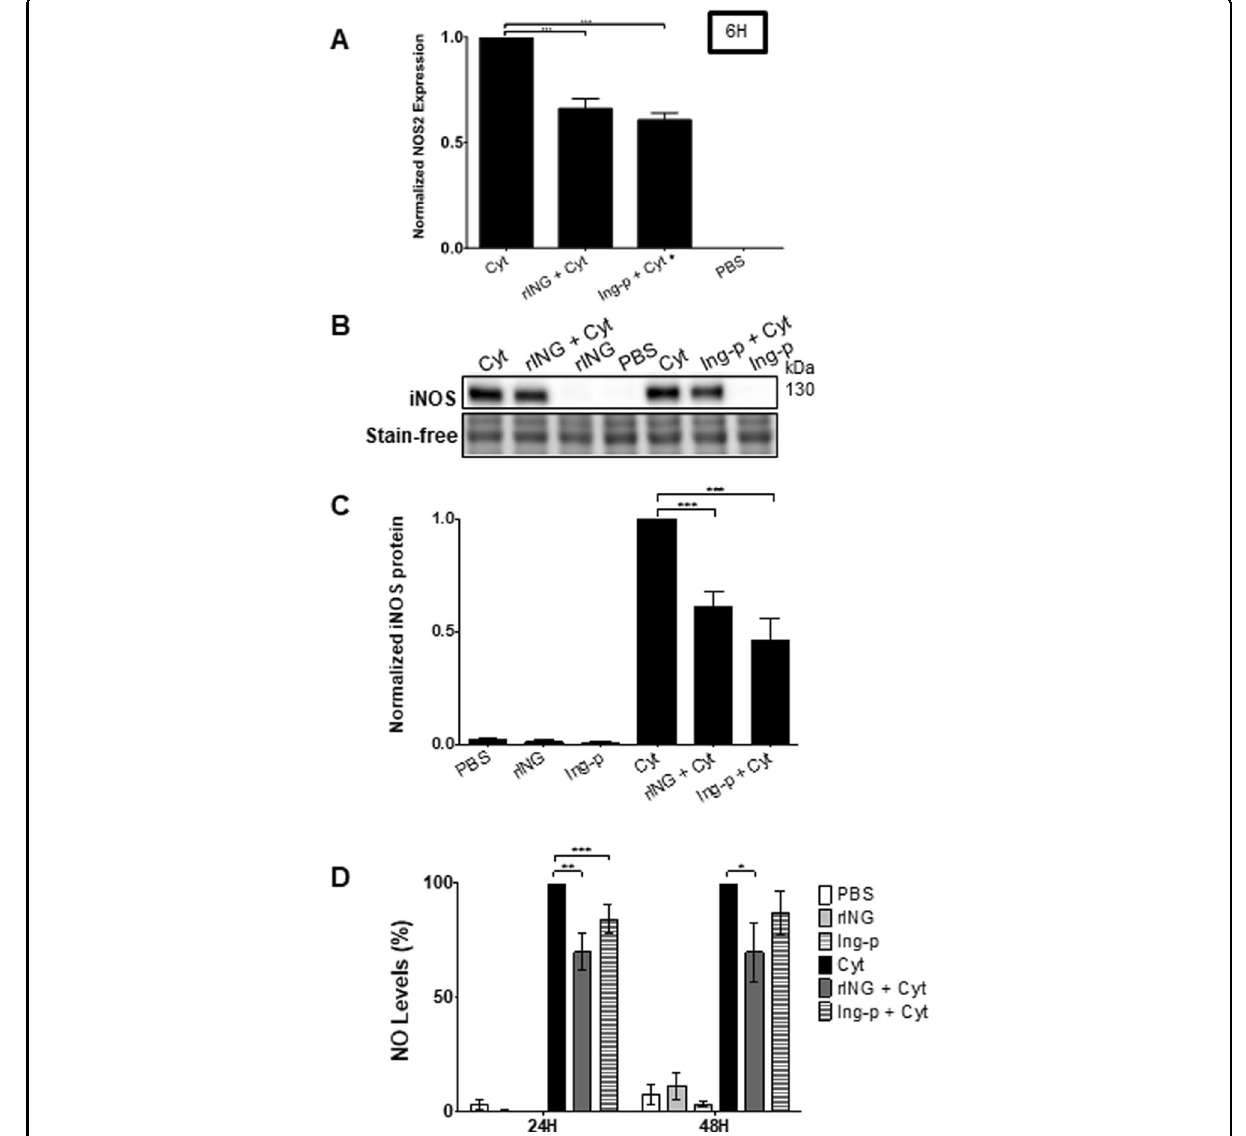
Fig. 2 INGAP pre-treatment decreases cytokine-induced Nos2 expression and NO production in RINm5F cells. RINm5F cells were pre-treated with 1 nM rINGAP or 1.67 μ M Ingap-p for 2 h prior to exposure to cytokines for 6 h. A Nos2 mRNA was assessed by qRT-PCR using the ΔΔ Ct method and normalized to cytokines only ( = 1). B , C Assessment of iNOS protein by Western blot: B Representative stain-free blots of cell lysates after 6 h cytokine exposure; C densitometric analysis presented as relative quantities of iNOS normalized to total lane protein and expressed as fold change. D NO levels in culture medium were assessed by Griess assay after 24 and 48 h. Data were normalized to cytokines only treatment and expressed as a percentage. * P < 0.05, ** p < 0.01, *** p < 0.001 vs. treatment with cytokines only; A , C one-way ANOVA with Bonferroni corrected multiple comparisons; D two-way ANOVA with Bonferroni corrected multiple comparisons. Data represent the mean of at least three independent experiments ±